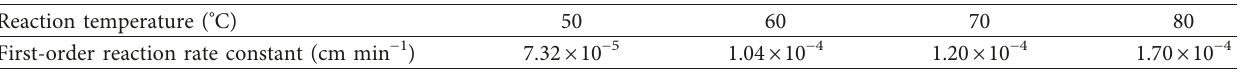
Table 4: The first-order reaction rate constant of surface chemical reaction at various reaction temperatures from 50 to 80 ° C. Reaction temperature ( °